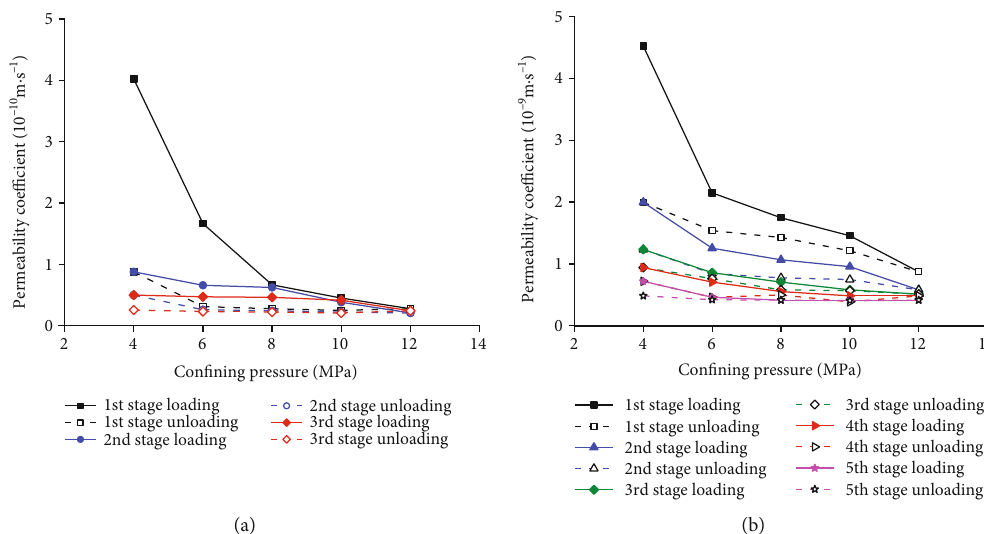
Figure 6: Relationship between the permeability coe ffi cient and the con fi ning stress under di ff erent loading and unloading cycles for fractured (a) sandstone and (b) granite specimens.